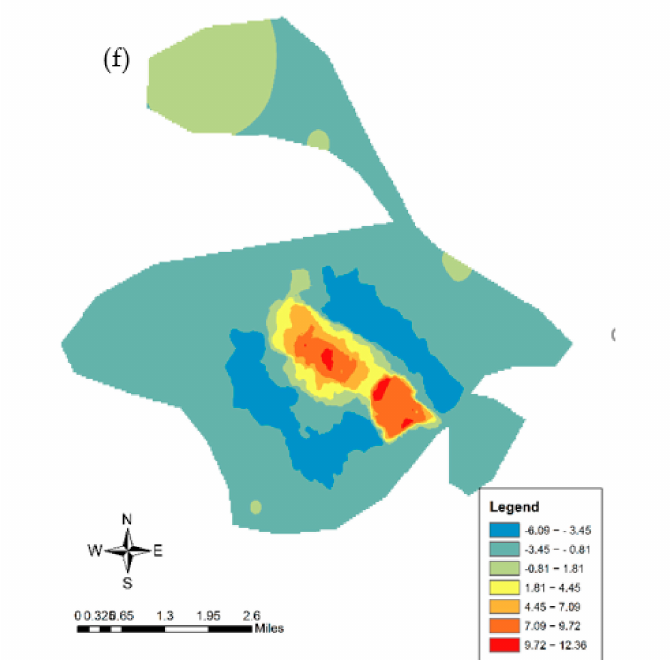
Figure 7. Hot spots and cold spots for pick-up and drop-off locations.